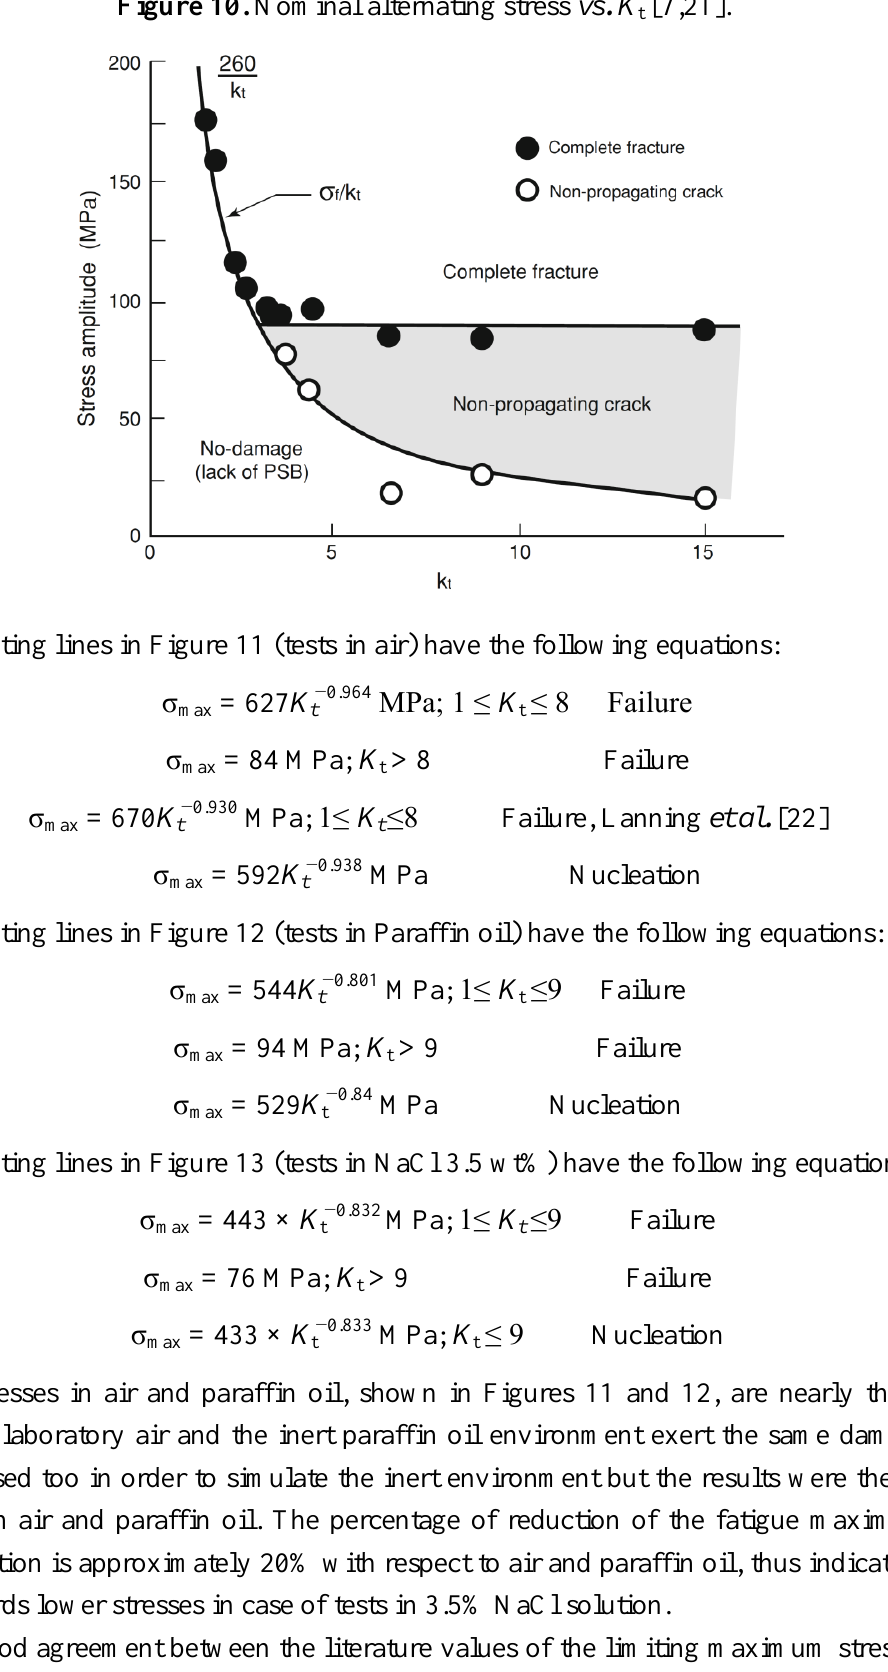
Figure 10. Nominal alternating stress vs. K